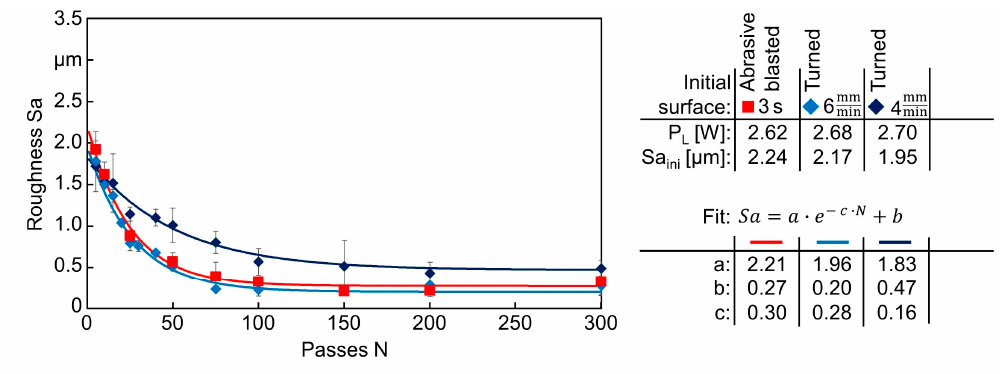
Figure 8. Roughness depending on the number of passes for constant initial roughness but different topography characteristics, as well as their exponential